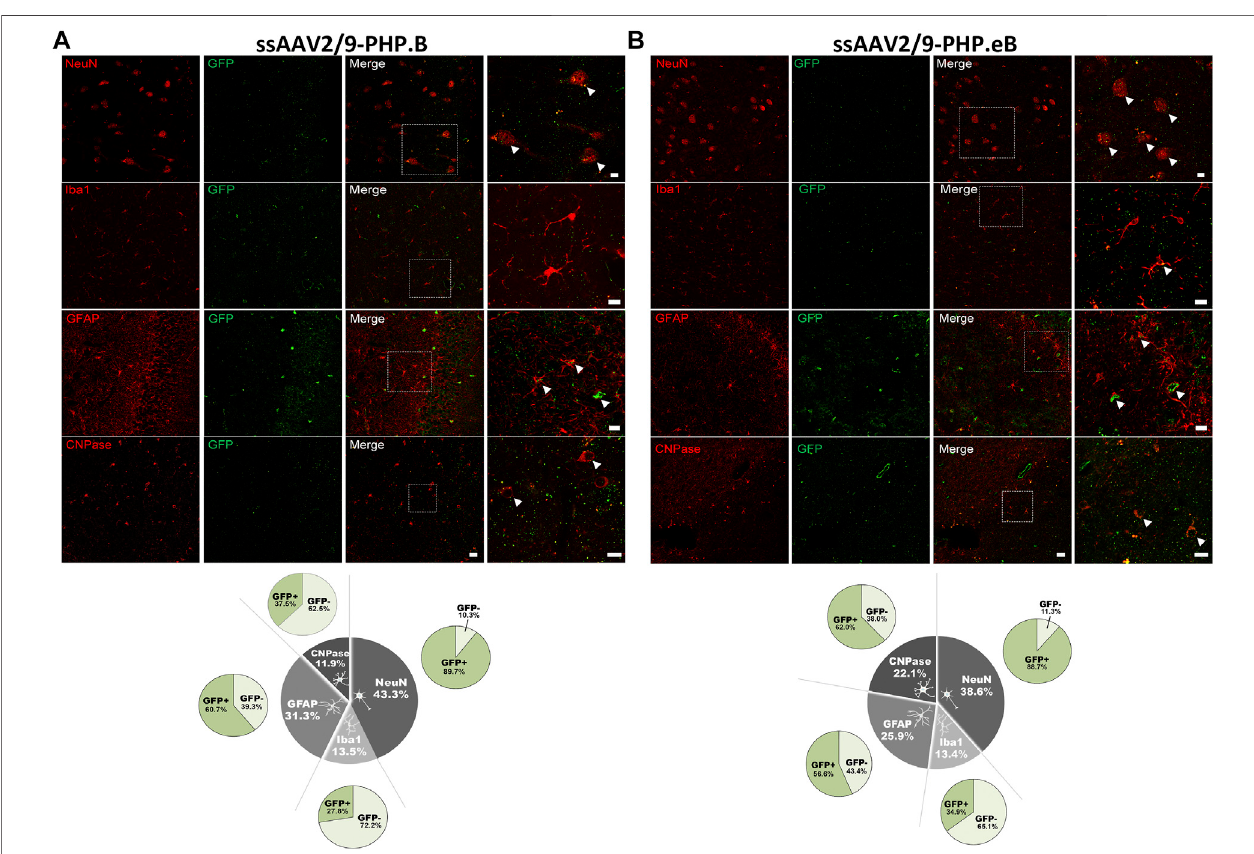
FIGURE 5 | Assessment of the cell-type speci fi city resulting from AAV-PHP. B and AAV-PHP. eB injections in the hippocampus of non-human primates. (A – B) Representative images (up) and quanti fi cations (down) of striatal sections from AAV-PHP. B-injected monkey (A) and AAV-PHP. eB-injected monkey (B) immuno fl uorescently labeled with anti-GFP antibody (green) and either a neuronal (NeuN), microglia (Iba1), astrocytic (GFAP + S-100) or oligodendroglial (CNPase) marker (red). Merging of the signals produced colocalization, thus con fi rming cellular transduction. Scale bar: 20 µm; 10 µm (high magni fi cation). White arrows represent the AAV-GFP transduced cells. Quantitative analysis of percentage of cell types counted for each viral vector in the hippocampus of injected monkeys (grey) and percentage of cells transduced (dark green) or not (light green) per cell type.